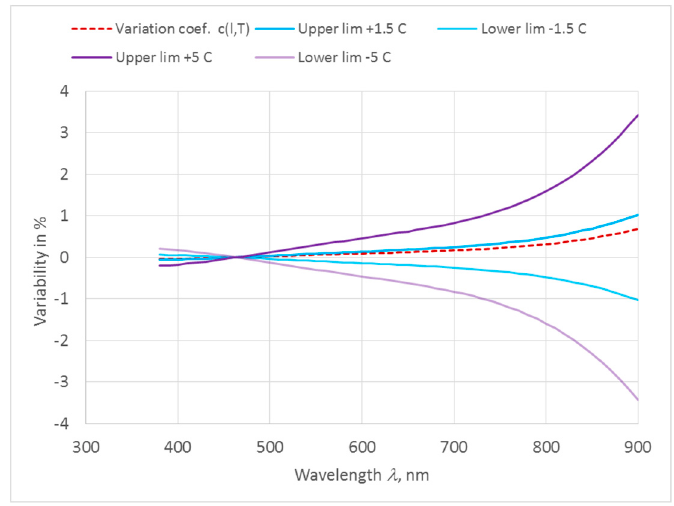
Figure12. Relativevariabilityofcalibrationcoe ffi cientsduetotemperaturedeviationsfromthereference Figure 12. Relative variability of calibration coefficients due to temperature deviations from the temperature 21.5 ◦ reference temperature 21.5 °C.